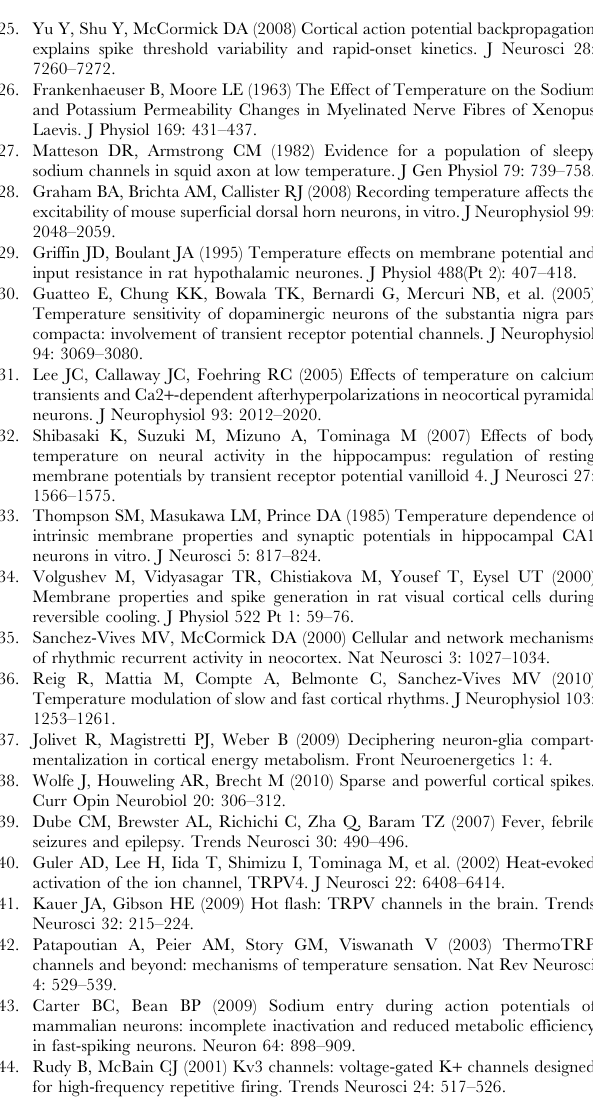
true for Na + channel inactivation (h) or K + channel activation (n). Here, the phase plots still exhibit substantial deviations from steady state values during action potential generation. (TIF) Figure S3 Increasing temperature increases firing rate during spontaneous Up states in entorhinal cortical slices. A. Example of an Up-state generated spontaneously in the medial entorhinal cortex at 23 u C. B. Up states at 36 u C. C. Up states at 42 u C. Note the increase in Up rate, and increase in action potential discharge during each Up state. D–F. Action potential discharge rate (D), action potential duration (E), spike threshold (F) for action potentials occurring during Up states as a function of temperature. G. Resting membrane potential during the Down state at different temperatures. All data obtained from layer 2/3 pyramidal neurons (n =6) in the mouse medial entorhinal cortex. (TIF) Figure S4 Effects of changing specific membrane resistance (decrease by 35%) and membrane potential (depolarization by 7 mV) on the relationship between temperature and firing rate in